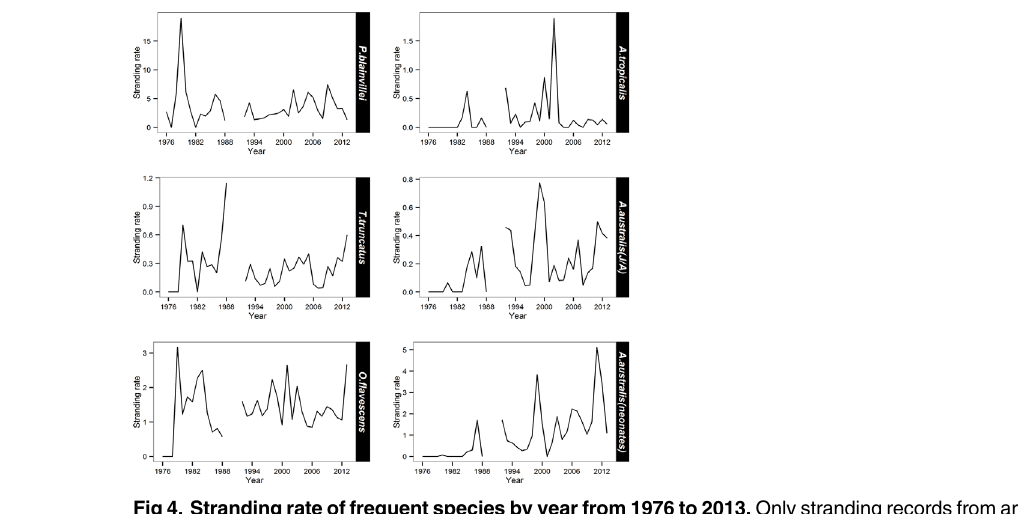
doi:10.1371/journal.pone.0146339.g004